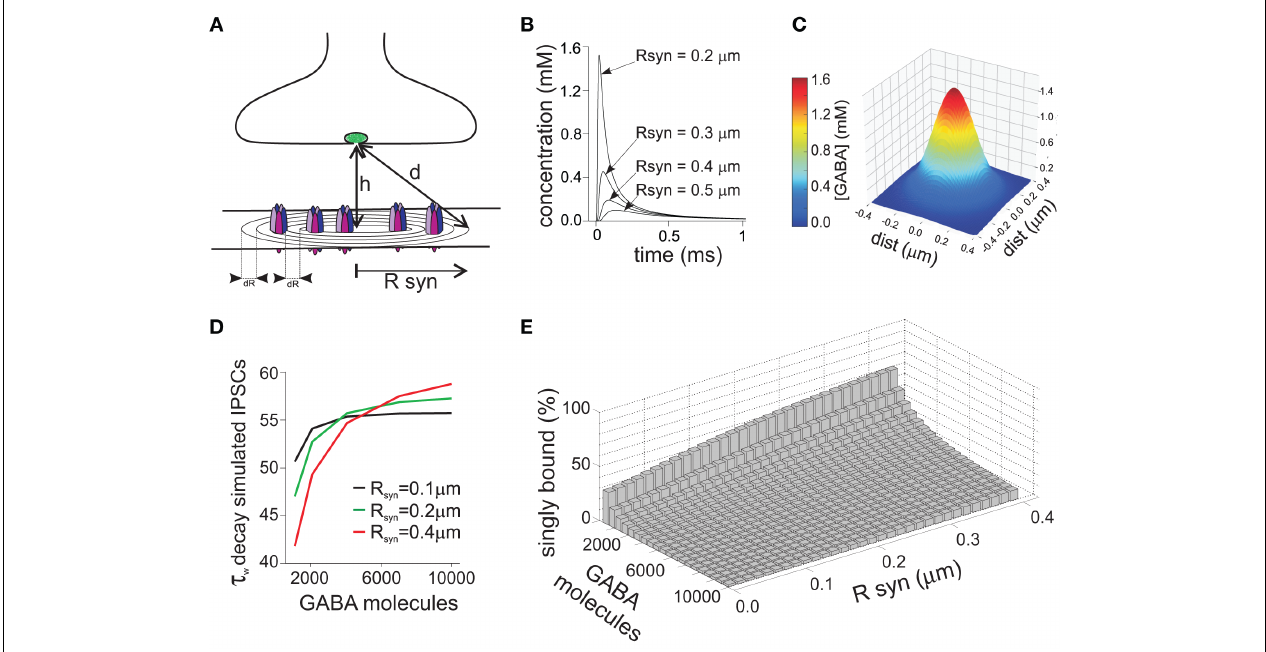
simulated IPSCs on the number of GABA molecules released. At low number of GABA molecules released, receptors located at the disk periphery sense a low dose of GABA, activating preferentially in the monoliganded configuration, and contributing therefore to IPSCs speed-up. Please note that the IPSCs decay was also influenced by the synapse radius. (E) Summary of the relative weight of monoliganded GABA A R on the simulated IPSCs at different GABA molecules released and synaptic radiuses. Please note that conditions generating low saturation (low number of molecules released and/or large synaptic radiuses) favor the singly bound state activation, while high concentration pulses at small synapses determine almost complete activation in doubly bound state. Modified from Petrini et al. (2011) with